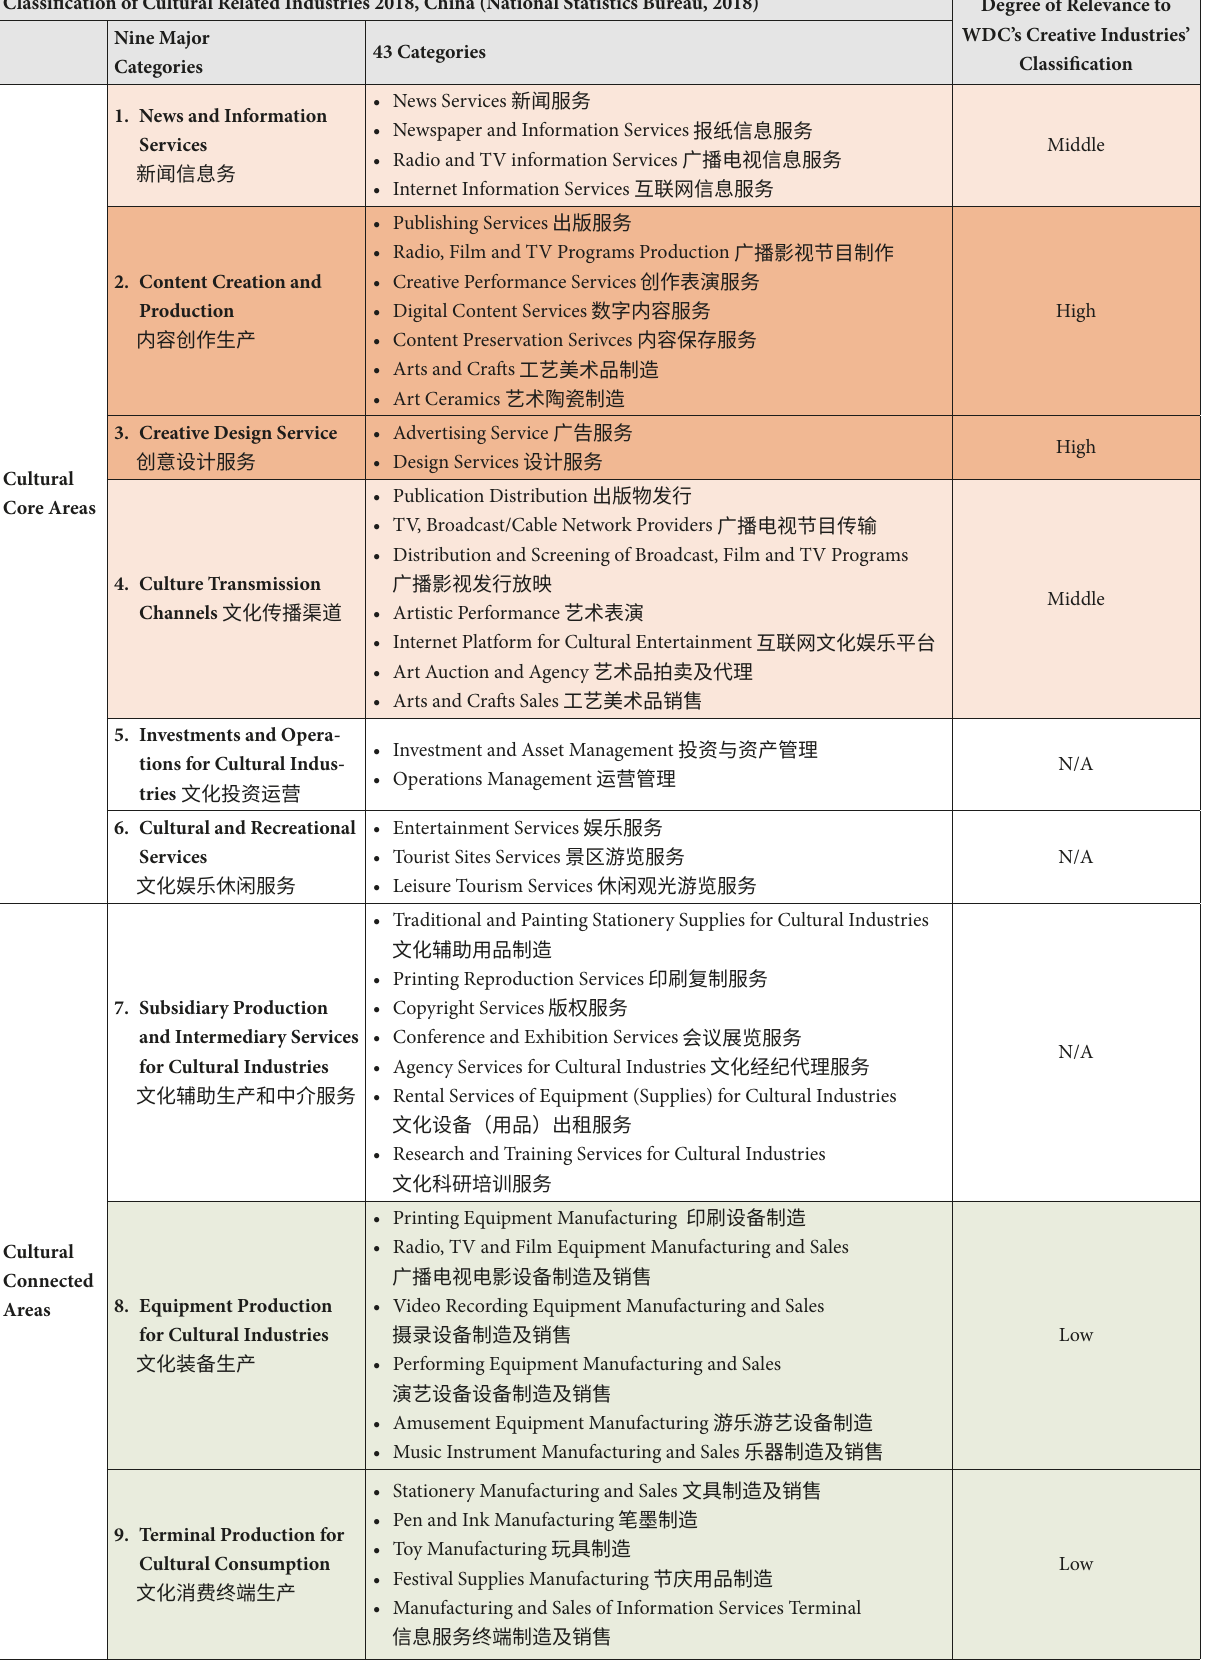
Table 1 The revised Chinese classifications of cultural industries published in 2018, and the degree of relevance to the WDC’s classification of creative industries (Source: the authors). Classification of Cultural Related Industries 2018, China (National Statistics Bureau,